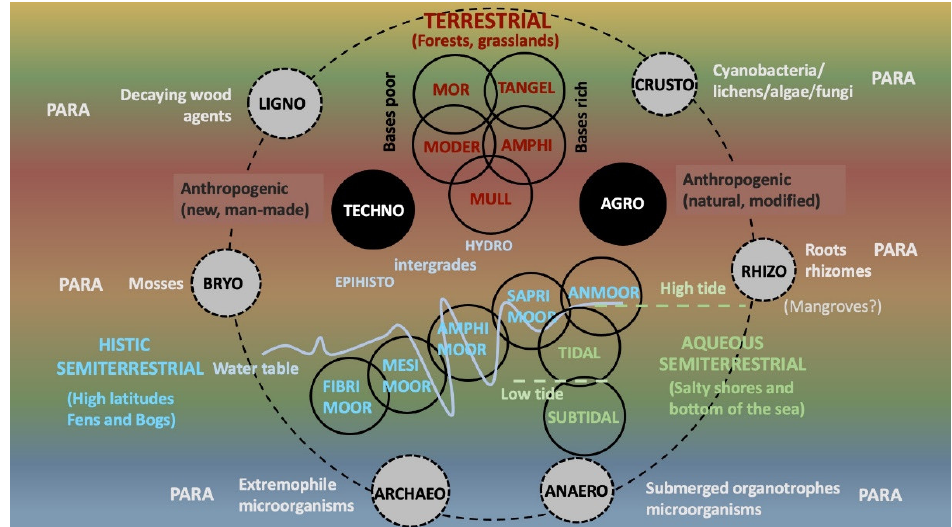
Figure 2. Slightly modified diagram (modified from [2]) showing all humus systems described in dedicated articles [44,52–56]. Terrestrial systems are placed at the top of a circle next to the Forests Grasslands title. They are divided vertically into non-Mull (Mor, Tangel, Moder Amphi) and Mull, and horizontally left to right into Bases poor (Mor and Moder) and Bases rich (Tangel and Amphi), with a nearly neutral Mull in between. Next to these, there are two anthropic systems, Techno (new systems manufactured by man) and Agro (natural systems modified by man for agricultural pur- poses) in black. Immediately below in blue are the partially submerged systems (Fens and Bogs, Histic systems), with a gray line indicating the oscillation of the water table (sometimes perched). From left to right of the figure, the systems pass from the permanently submerged Fibrimoor, to the Mesimoor, Amphimoor, Saprimoor, to arrive to the less-submerged (6 months per year, influenced by a slow oscillating water table) Anmoor. In the center of the circle, between the Terrestrial and Histic systems, there are the Hydro transitions closest to the Terrestrials’, and Epihisto more similar to the Histics’. The systems dependent on daily tidal cycles, called Aqueous, and divided into Tidal (submerged at high tide) and Subtidal (submerged even at low tide), are shown in green-blue at the bottom left. In gray along the dashed circle are the Para systems, which correspond to particular stages of the evolution of the soil. Initial and progressive stages are with the nonsubmerged systems Crusto, Bryo, Rhizo, and Ligno, or submerged such as Archaeo and Anaero. One has likely already seen very common Bryo systems even on walls or roofs of houses; they are classified as Edifisoils by Markiewicz et al. [57]. These Para systems can exist alone or in combination with other systems. Reprinted/adapted with permission from Ref. [2]. 2018, App. Soil Ecol.”. More details on “Copyright and Licensing” are available via the following link: https://www.mdpi.com/ethics#10 (accessed on